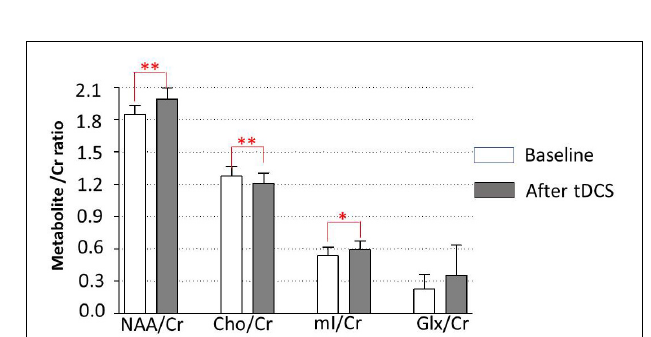
FIGURE 3 | Metabolite changes in the left dorsolateral prefrontal cortex. Data are presented as means of NAA/Cr, Cho/Cr, mI/Cr, and Glx/Cr concentrations, compared between baseline (before tDCS) and after a 5-day tDCS treatment (day 5). Vertical lines represent SD. ∗ Represents a significant difference; ∗ p < 0.05.